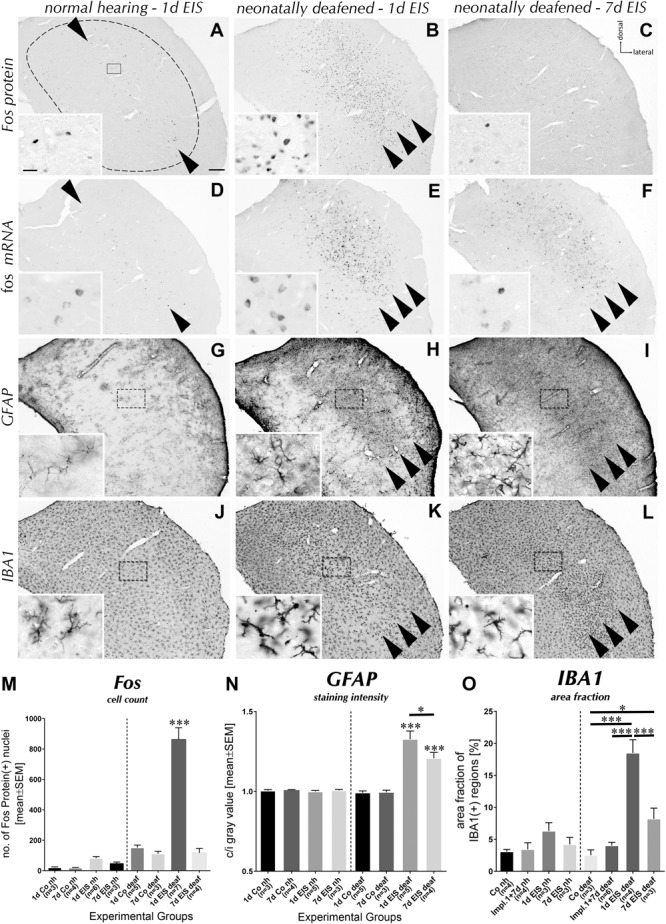
Effects of EIS in the contralateral CIC of hearing-experienced and deafened rats. (A) EIS induced Fos expression in a sharp tonotopically defined band across CIC (arrowhead) of nh rats. (B) Despite identical electrode position and stimulation parameters, Fos expression in deaf rats was extensive and spatially unrestricted within CIC after 1 d EIS (arrowheads). (C) After sustained EIS for 7 d of deaf rats, Fos expression was no longer where it has been before. (D) Like the protein, fos mRNA emerged in a tonotopic band of CIC after 1 d EIS of hearing-experienced rats (arrowhead). (E) Under otherwise identical stimulation conditions in deaf rats, fos mRNA was expressed by many neurons almost throughout CIC (arrowheads). (F) Unlike the protein, fos mRNA persisted even after 7 d EIS (arrowheads) of deafened rats. (G) GFAP staining remained apparently unchanged by EIS in hearing-experienced rats. (H) In deaf rats, a massive rise of GFAP staining intensity was seen in regions of high fos mRNA and protein expression (arrowheads). (I) GFAP staining was still elevated after 7 d of sustained EIS in deaf rats. (J) IBA1 staining remained apparently unchanged after EIS in hearing-experienced rats. (K) There was a striking change in microglia morphology after 1 d EIS of (deaf rats in the region of high fos mRNA and protein expression (arrowheads). (L) By 7 d of EIS, microglia morphology was no longer as extreme as by 1 d EIS but still not back to normal. (M) Counting Fos protein positive cells in entire CIC cross-sections (dashed line in A), a significant rise was identified after 1 d EIS in hearing and deaf rats, which decreased again toward 7 d EIS. Group “1 d EIS deaf” differs significant (p < 0.001) against all other groups. Group “1 d EIS nh” differs significant against all other hearing groups with p < 0.001 or p = 0.027 for “1 d EIS” vs. “7 d EIS.” (N) The contralateral (c) to ipsilateral (i) ratio of GFAP staining intensity as determined in the frames indicated in G to I and their mirror-symmetrical counterparts in ipsilateral CIC was significantly shifted in favor of the contralateral side in deaf but not in hearing-experienced rats after 1 d EIS (p < 0.001 against all groups except “7 d EIS deaf” with p = 0.0333). By 7 d EIS, it has decreased again (∗ against “1 d EIS deaf”) but was still elevated against all other groups (p < 0.001). (O) Quantification of area fraction of IBA1 as determined in the frames indicated in (J–L) in contralateral CIC. A significant increase was identified after 1 d EIS of deaf rats, which decreased again toward 7 d EIS. Group “1 d EIS deaf” differs significant against all other groups (p = 0.016 for Co vs.7 d EIS deaf; p < 0.001 for all others). Co, Control with passive electrode implantation; nh, normal hearing; n, number of animals from which data were sampled. Scale bar for major panels: 200 μm; scale bar for insets: 10 μm.)